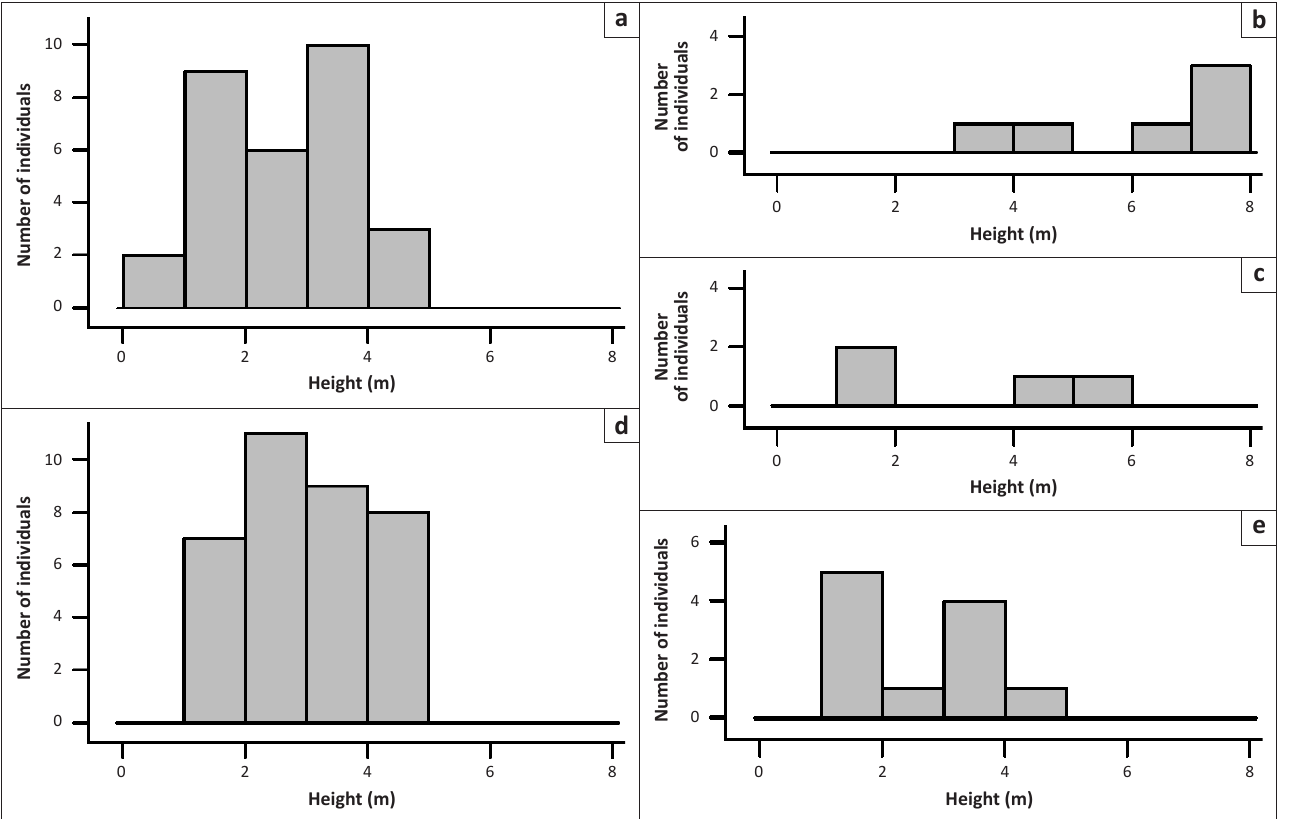
FIGURE 5: Size class distributions of Dalbergia melanoxylon populations growing (a) inside, Combretum imberbe populations growing (b) inside and (c) outside and Colophospermum mopane populations growing (d) inside and (e) outside of the N’waxitshumbe exclosure. No Dalbergia melanoxylon plants were found growing on the outside of the exclosure in the Kruger National Park. TABLE 3: Mean (± s.e.) values of the measured leaf traits for the inside and outside treatments of three exclosures in the Kruger National Park. Trait Makhohlola